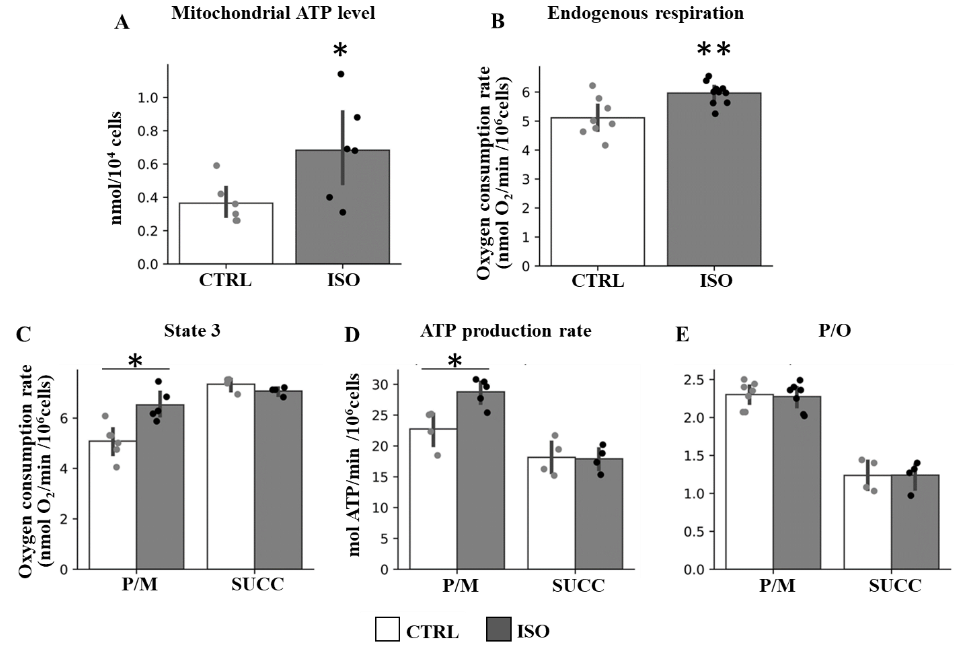
Figure 2. Effect of isoproterenol treatment on oxygen consumption rates, ATP level, ATP production rate and efficiency. The H9c2 cell cultures were incubated in absence (CTRL) or in the presence of isoproterenol (ISO). ( A ) The scatter bar graphs represent the mitochondrial ATP level determined as result of total ATP level minus ATP level in the presence of oligomycin. ( B ) The scatter bar graphs represent the oxygen consumption rates measured in intact cells (endogenous). ( C ) The scatter bar graphs represent the oxygen consumption rates in digitonin-permeabilized cells supplemented with ADP and pyruvate plus malate (P/M) or succinate (SUCC) as respiratory substrates (State 3). ( D ) The scatter bar graphs represent the mitochondrial ATP production rates measured in the presence of P/M or SUCC. ( E ) The scatter bar graphs represent the P/O ratio measured in the presence of P/M or SUCC. The data represent the means ± SD of at least five different experiments except for succinate (four determinations). ISO vs. CTRL, * p < 0.05, ** p < 0.01, Student’s t -test.